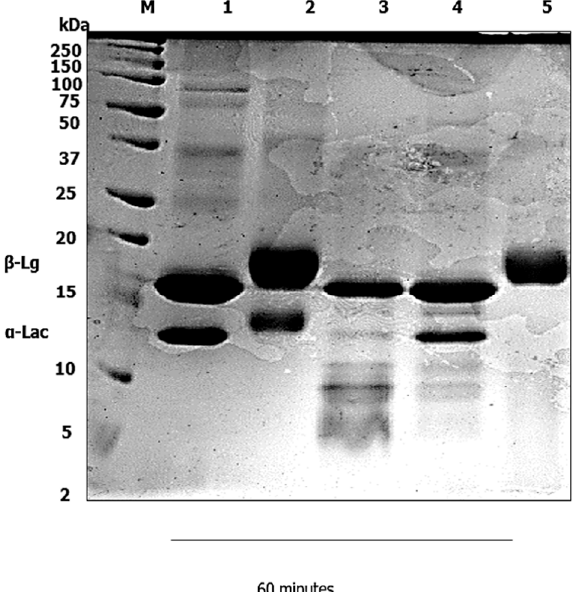
Figure 1. In vitro gastric digestion of native WPI using pepsin. The α -Lac of the native WPI partially hydrolyzed at early 30 min (Lane 4) with the presence of pepsin, and was not detectable at 60 min digestion (Lane 5). The WPI without pepsin was shown unaltered during gastric digestion. The β -Lg was detectable throughout the whole 60 min of gastric digestion. Lane 1: WPI without pepsin; Lane 2: 0 min; Lane 3: 5 min; Lane 4: 30 min; and Lane 5: 60 min. Lane M represents the protein marker.